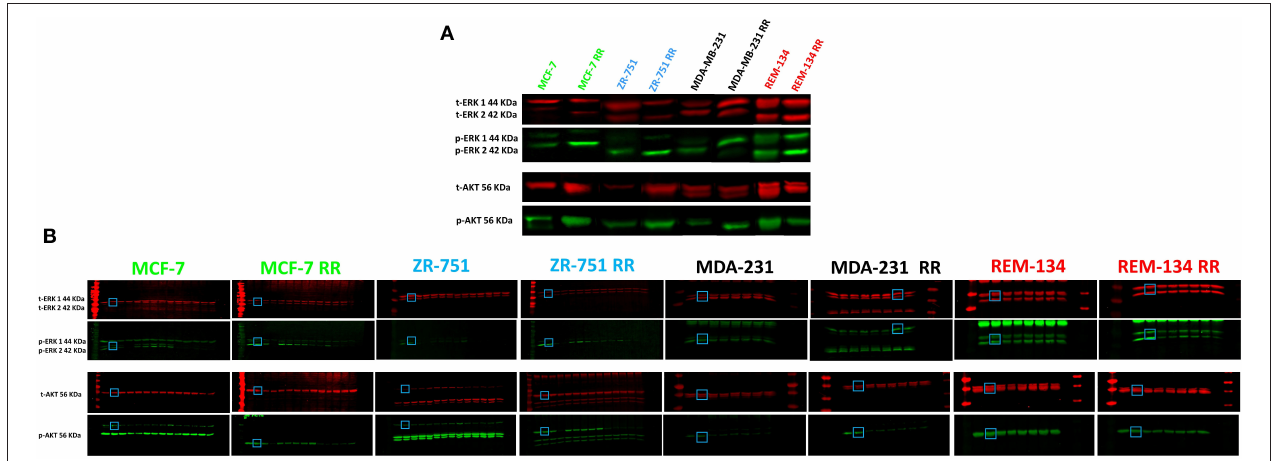
Supplementary Figure 6 | (A) Combined western blot showing total and phosphorylated ERK1 and ERK2 and total and phosphorylated pan-AKT in parental and RR cell lines. Splicing was performed in the images shown in part (b) to remove redundant lanes to produce this figure. (B) Original western blot images from radiation time course experiments in all 8 cell lines. Bands shown in part (a) are highlighted here, which represent untreated control